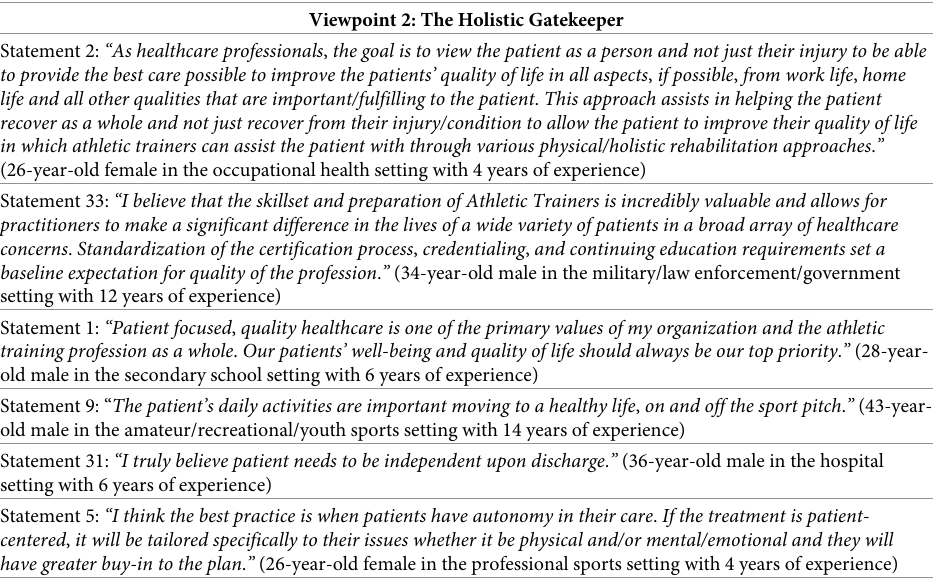
Table 2. Viewpoint 2 open-ended statements. Viewpoint 2: The Holistic